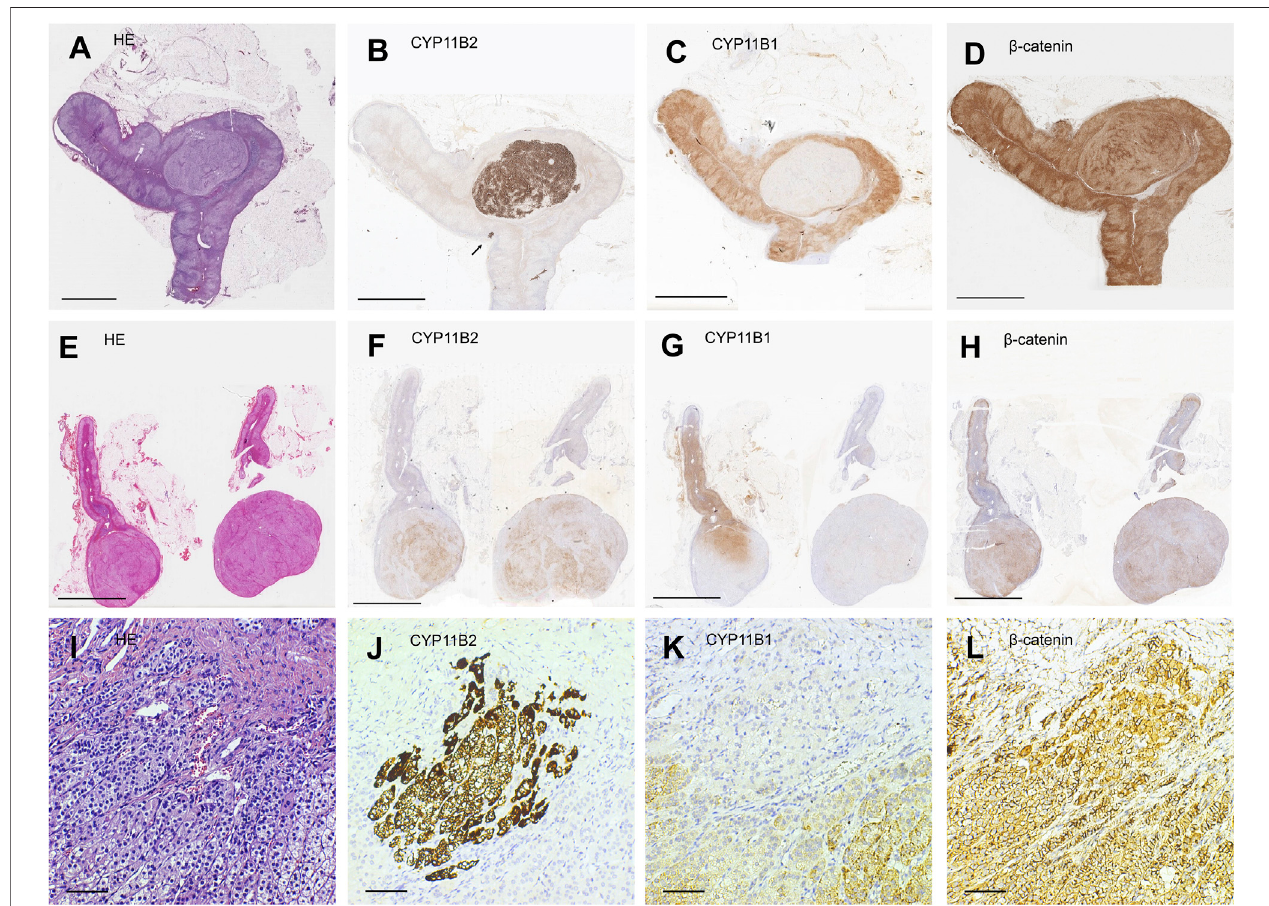
FIGURE 1 | Representative illustration of different subtypes of unilateral primary aldosteronism. (A,E,I) Hematoxylin-eosin staining. (B,F,J) Immunostaining for CYP11B2. (C,G,K) Immunostaining for CYP11B1. (D,H,L) Immunostaining for β -catenin. Scale bars, 5 mm (A – H) and 50 μ m (I – L) . (A – D) Representative illustration of aldosterone-producing adenoma (APA). (E – H) Representative illustration of multiple APA. (I – L) Representative illustration of an aldosterone-producing cell cluster (APCC) whose site is indicated by a black arrow in (B) .